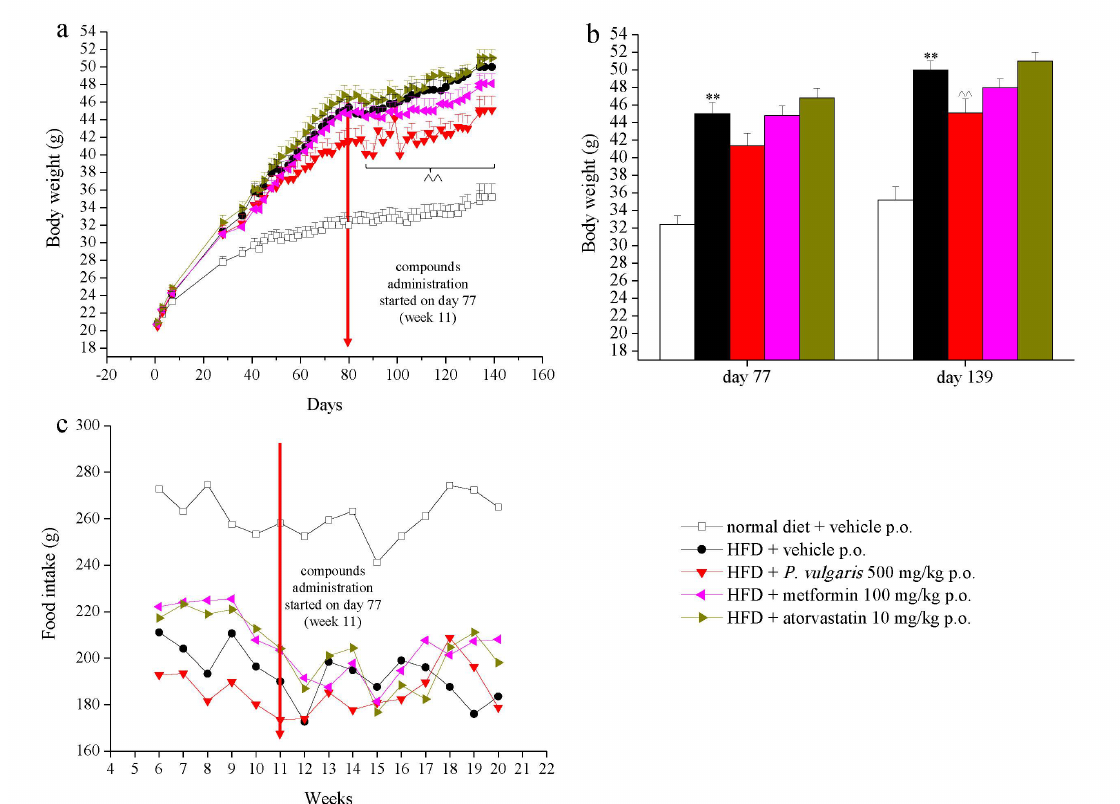
Figure 1. Body weight and food intake. Mice were fed with a normal or a high fat diet (HFD) for 139 days. From day 77 (week 11), the animals were treated daily with vehicle (CMC 1%), P. vulgaris extract 500 mg / kg per os (p.o.), metformin 100 mg / kg p.o., and atorvastatin 10 mg / kg p.o. ( a , b ) Animals’ body weight evolution, and ( c ) Animals’ food intake evolution. Red arrows point to the beginning of compound administration (day 77, week 11). Each value represents the mean ± S.E.M. of 12 mice per group. ** p < 0.01 vs. normal diet + vehicle; ˆˆ p < 0.01 vs. HFD +